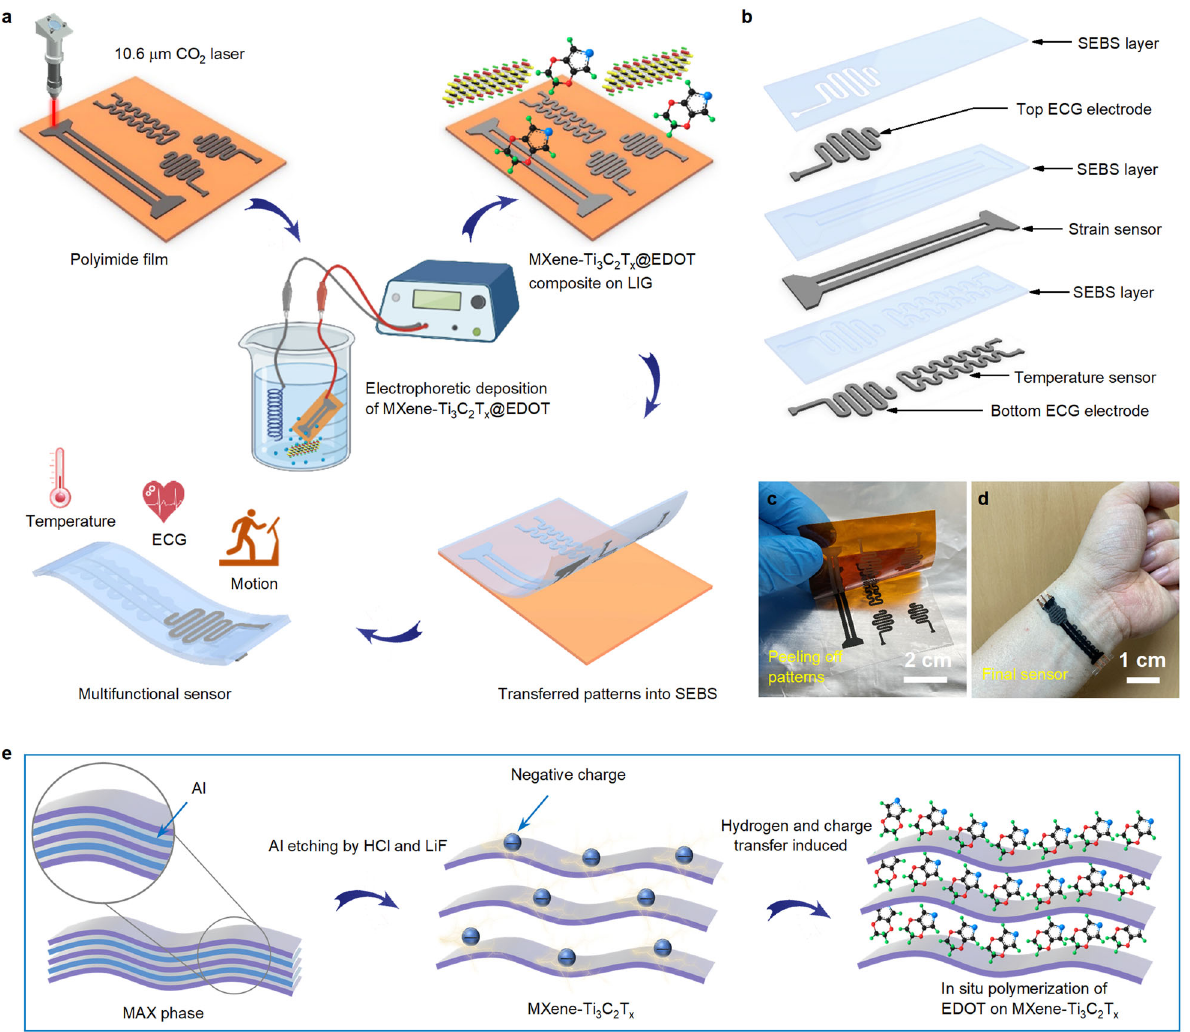
Fig. 1 Illustration of fabrication of multifunctional sensors. ( a ) Schematics of the fabrication of the LIG/MXene-Ti 3 C 2 T x @EDOT-based multifunctional sensors. ( b ) Layered view of the sensors. Photograph of the ( c ) transferring of LIG/MXene-Ti 3 C 2 T x @EDOT patterns into SEBS and ( d ) fi nal sensor. ( e ) Mechanism of in-situ polymerization of EDOT on MXene. (Photo credit: Shipeng Zhang, Kwangwoon